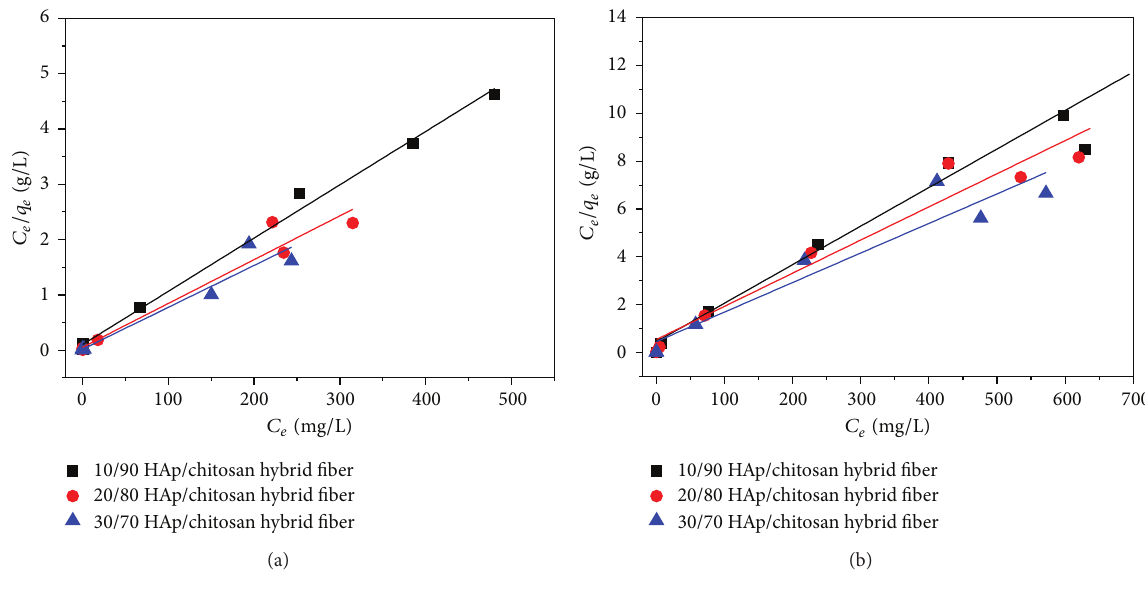
Figure 4: Langmuir isotherm model for adsorption of (a) Pb 2+ and (b) Cd 2+ on hybrid fibers with different HAp/chitosan ratio (10/90 (square), 20/80 (circle), and 30/70